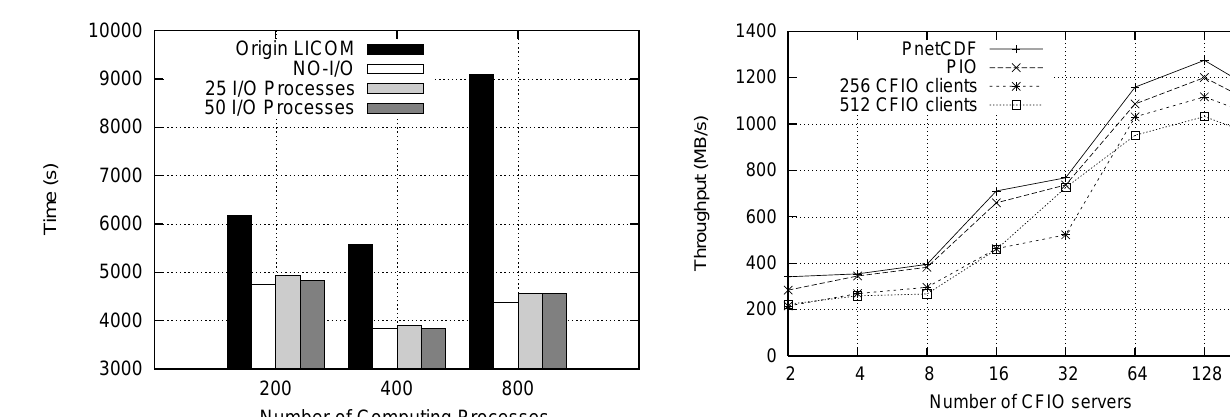
Fig. 8. The overall running time of LICOM with different I/O ap- proaches.